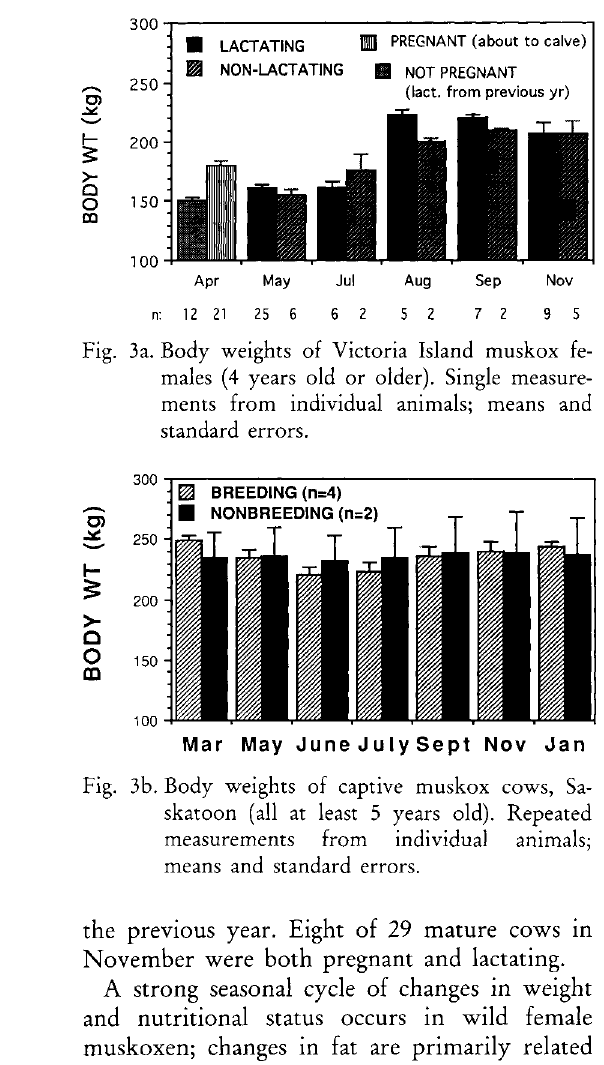
Fig. 4. Carcass weights of Victoria Island muskox fe males (4 years old or older). Single